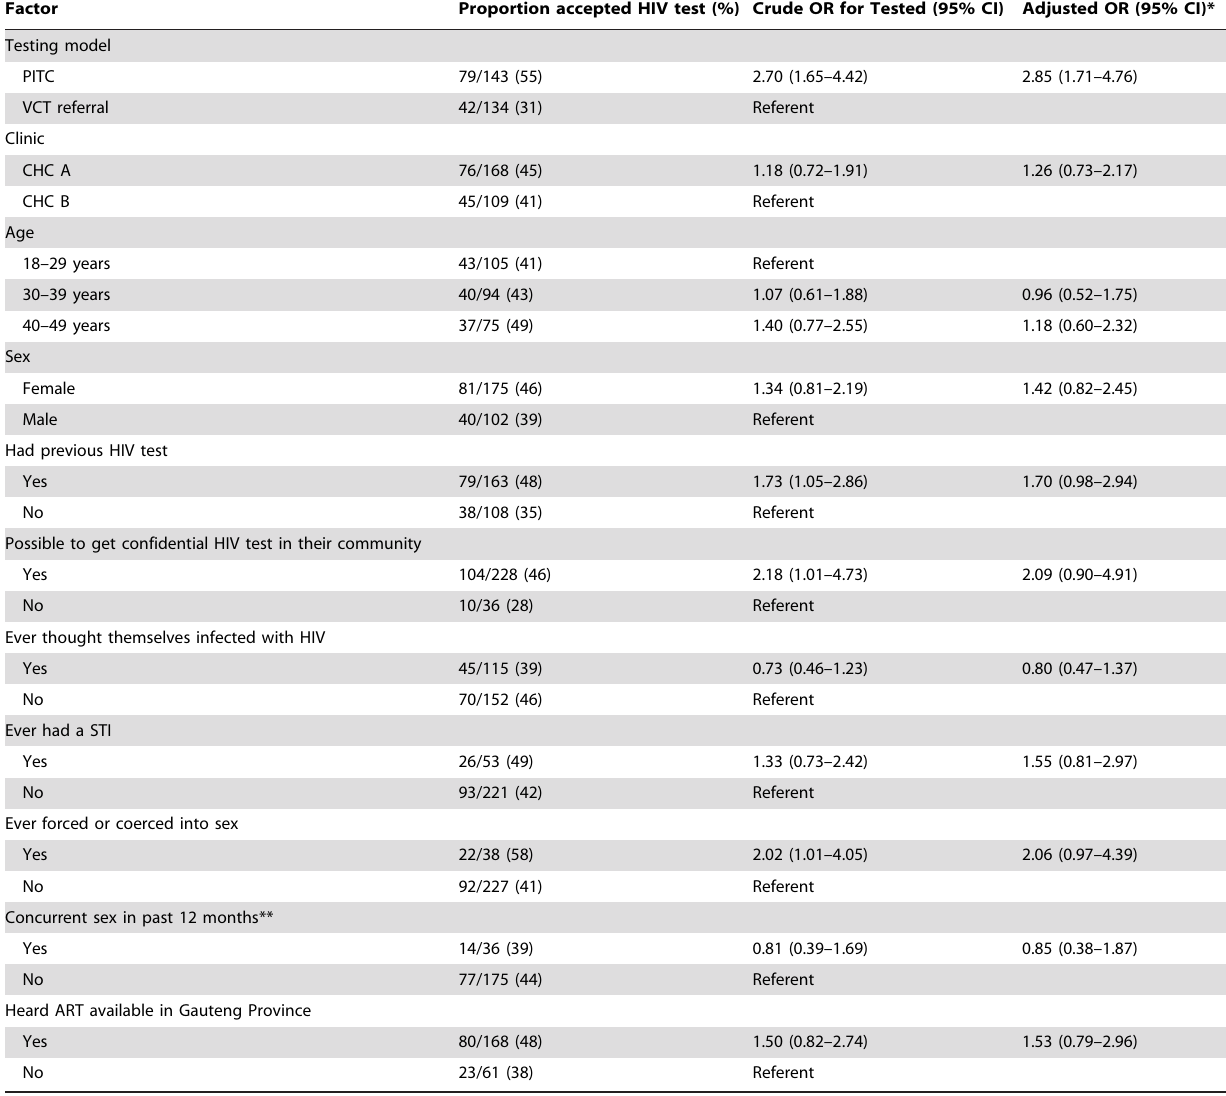
Table 2. Multiple logistic regression of selected pre-test factors with accepting an HIV test among 277 outpatients referred to VCT or offered a test by their provider